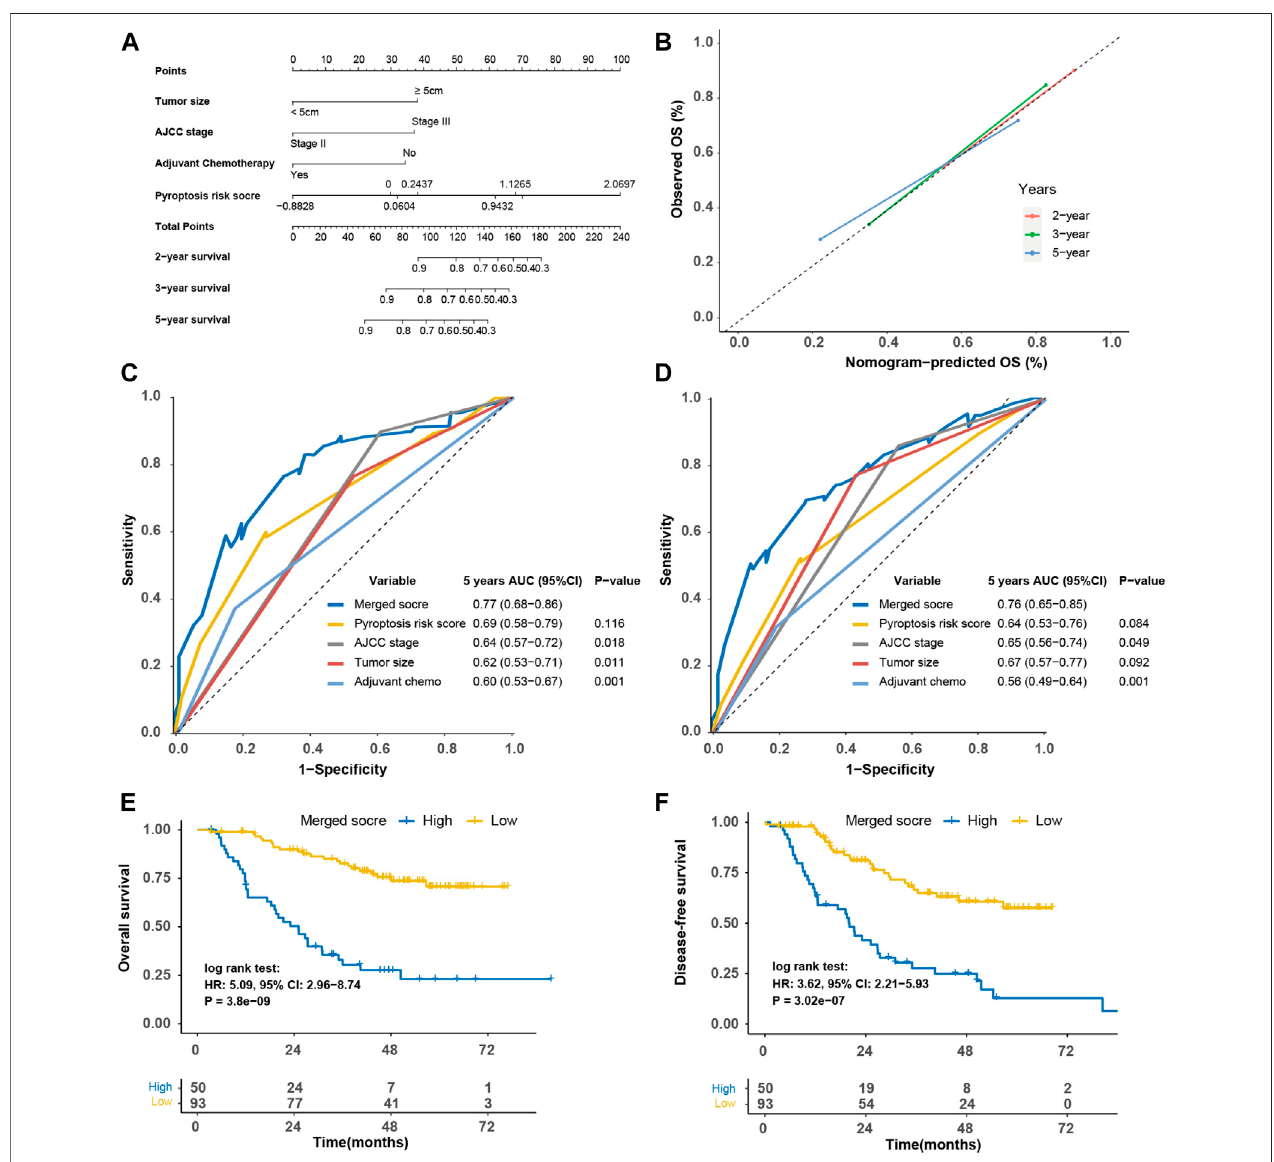
FIGURE 8 | Construction of merged risk score in the SYSUCC cohort. (A) A merged score was constructed by nomogram COX regression based on the pyroptosis risk score, tumor size, adjuvant chemotherapy and TNM stage in the SYSUCC cohort. (B) Calibration curve of the nomogram regarding the predicted and observedsurvival.Comparisonofthemergedscoreandothervariablesintermofoverallsurvival (C) anddisease-freesurvival (D) .Kaplan-Meiercurvesofoverallsurvival (E) and disease-free survival (F) of high- and low-merged score. SYSUCC, Sun Yat-Sen University Cancer center.